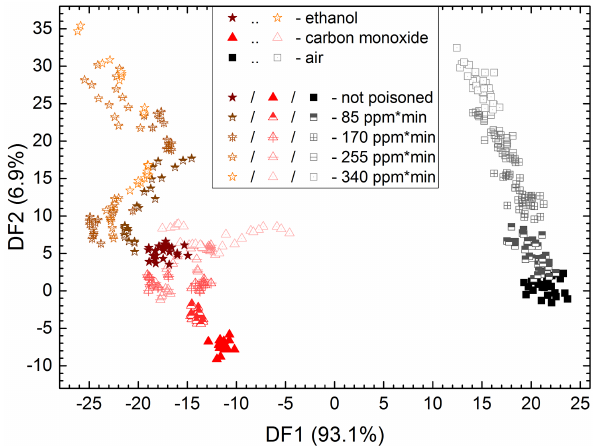
Figure 3. LDA plot showing the discrimination of different gases using data from different poisoning states. The DFs were calculated with data acquired before poisoning (solid symbols), and applied to data from all poisoning states. The 24 features used for this LDA are based on normalized conductance values, i.e. a linear projection of all conductance values of a temperature cycle to the interval [0, 1].